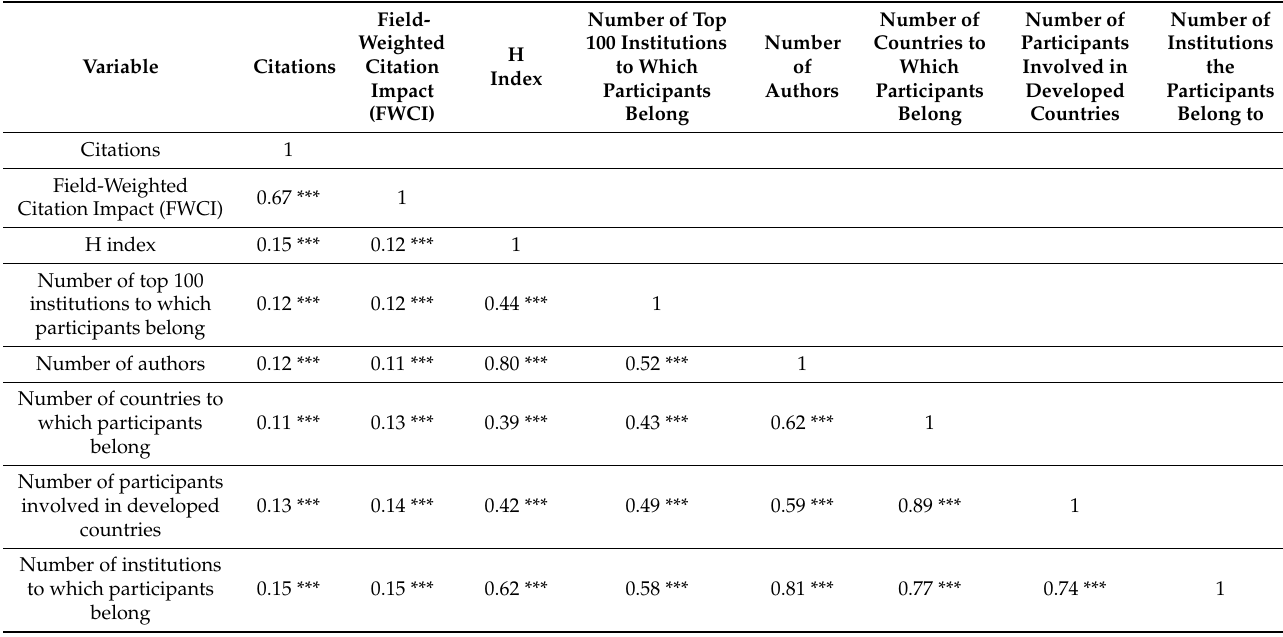
Table 3. Correlation test.